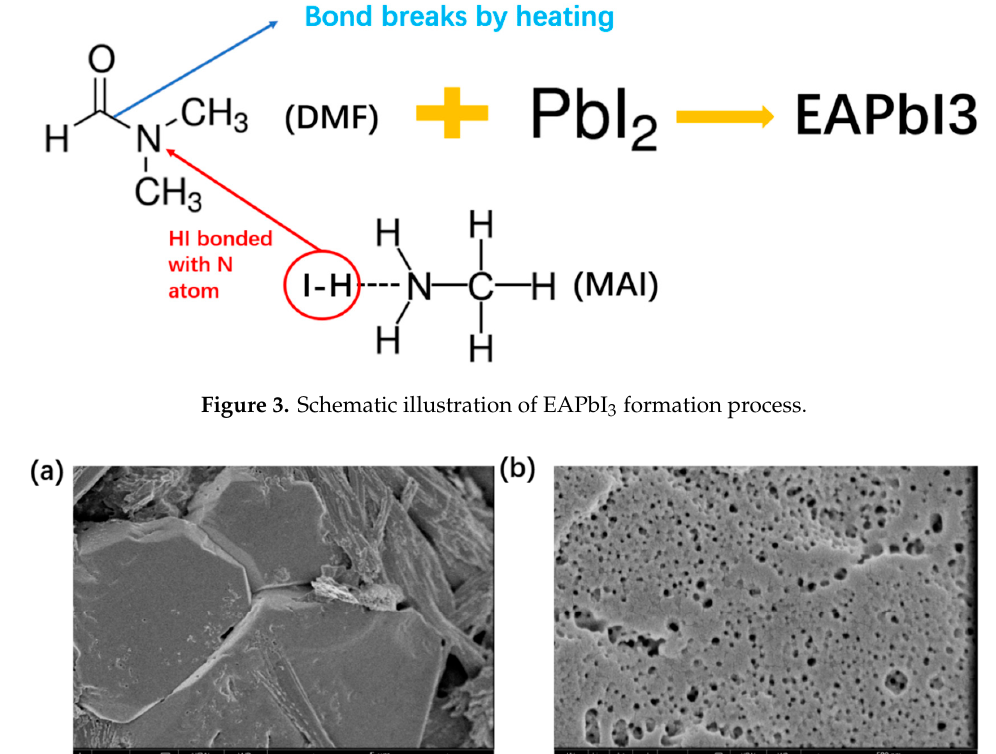
Figure 4. ( a ) Morphology of CH 3 NH 3 PbI 3 film with no EAPbI 3 ; ( b )Morphology of CH 3 NH 3 PbI 3